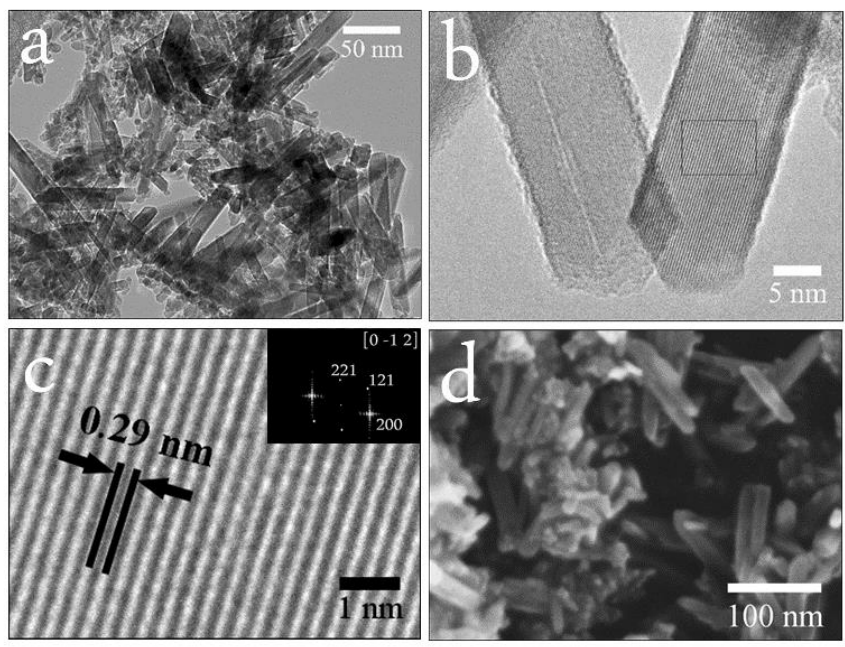
Figure 2. ( a ) TEM image of brookite nanorods; ( b) HRTEM of brookite nanorods. The area inside the black frame is magnified in ( c ) and the FFT pattern is shown in the inset. The reflections in the FFT pattern could be indexed with a zone axis along the [0–12] direction. ( d ) SEM image of the grown brookite nanorods.